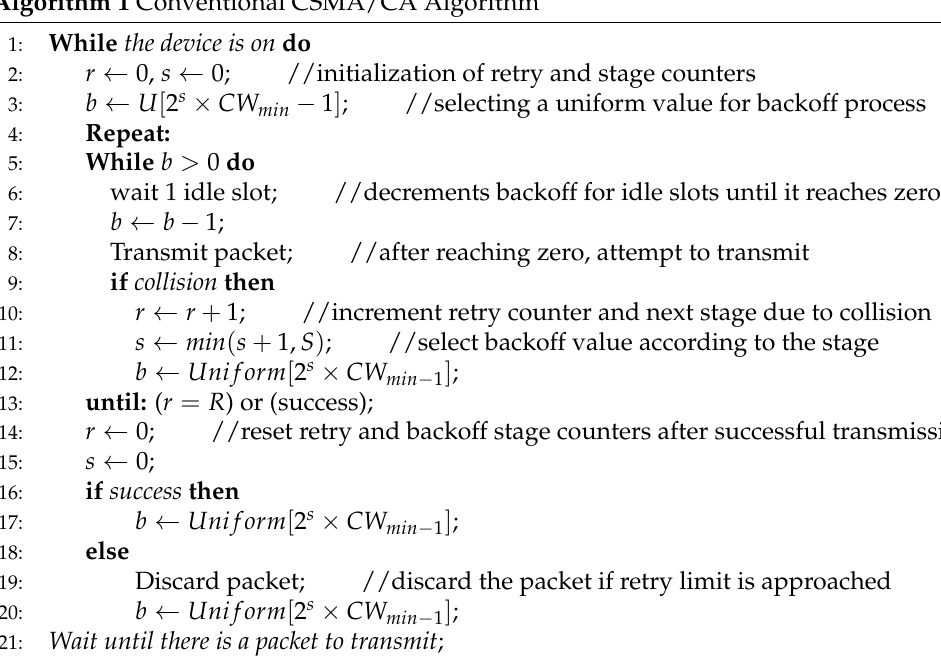
Algorithm 1 Conventional CSMA/CA